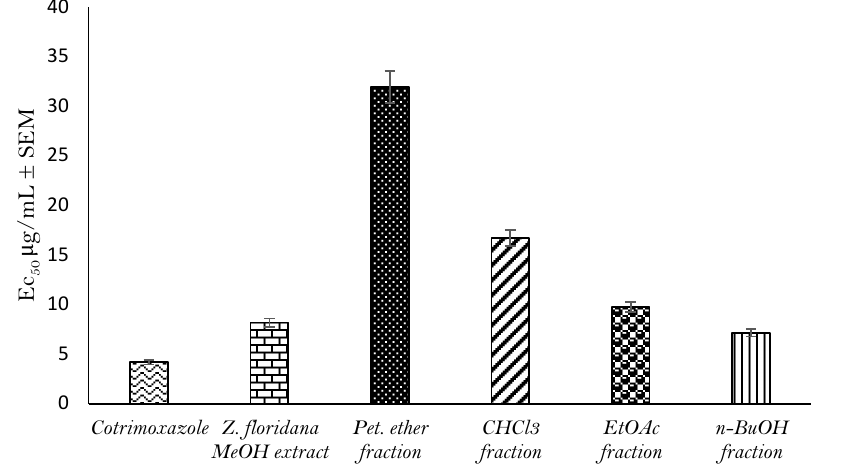
Figure 1. Toxoplasmocidal effect (EC 50 ± SEM) of Z. floridana methanol extract and its different fractions against T. gondii .